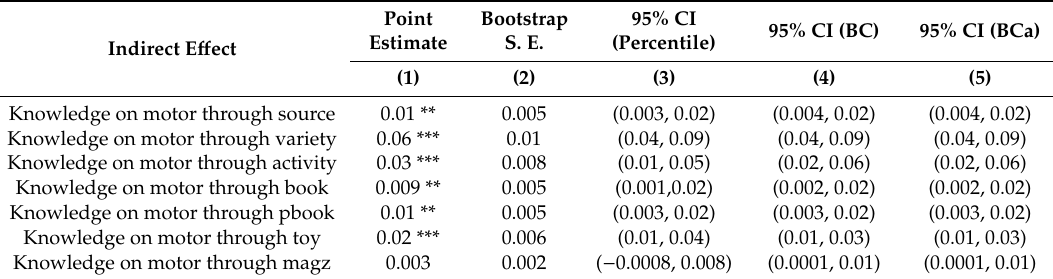
Table 6. Estimates of indirect e ff ects of parenting knowledge on motor development through di ff erent parental investments.